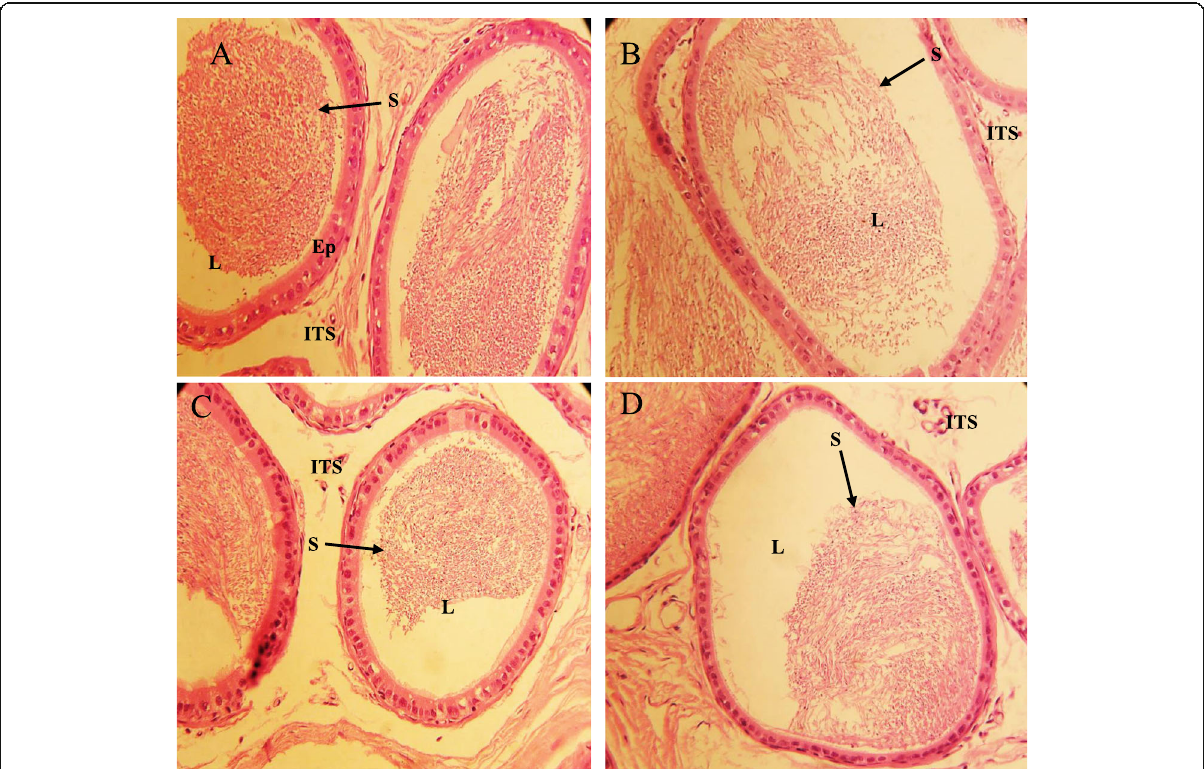
Fig. 3 Photomicrograph of cauda epididymis tissue showing ( a ) control; with a compact arrangement of cauda tubules with sperm filled lumen ( b ) BPS (0.5 μ g/L)-exposed group, presenting normal caput tubules like in the control ( c ) BPS (5 μ g/L)-exposed group, presenting cauda tubules with sperm filled lumen ( d ) BPS (50 μ g/L)-exposed group presenting cauda tubules with less sperm in the lumen. H&E (×